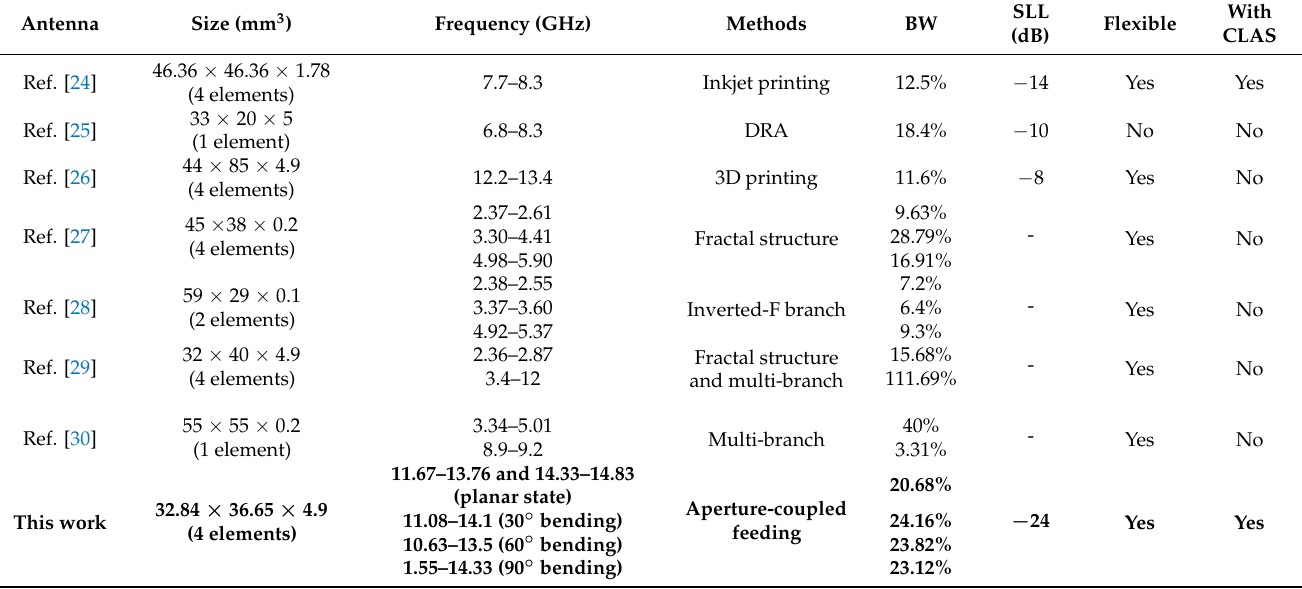
Table 4. Comparison between proposed and similar conformal antenna